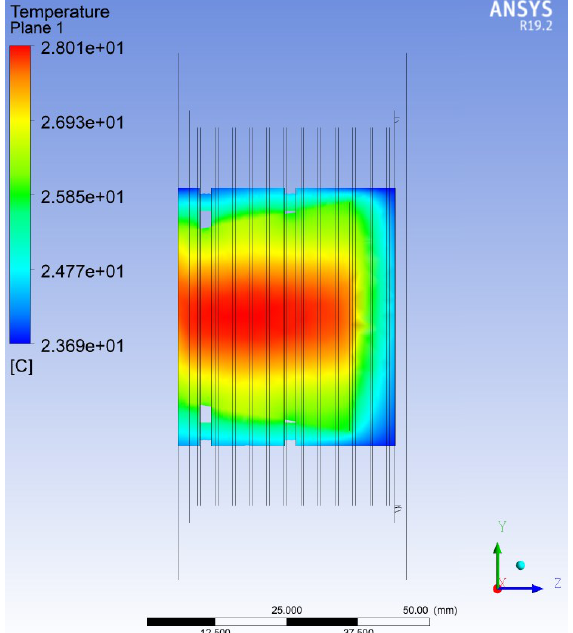
Fig. 9. Temperature map of the Be and Galinstan of a preliminary ANSYS model of CoolGal with water coolant for a 1  A current of 70 MeV protons (70 W). The maximum temperature of the Be component is 28°C.